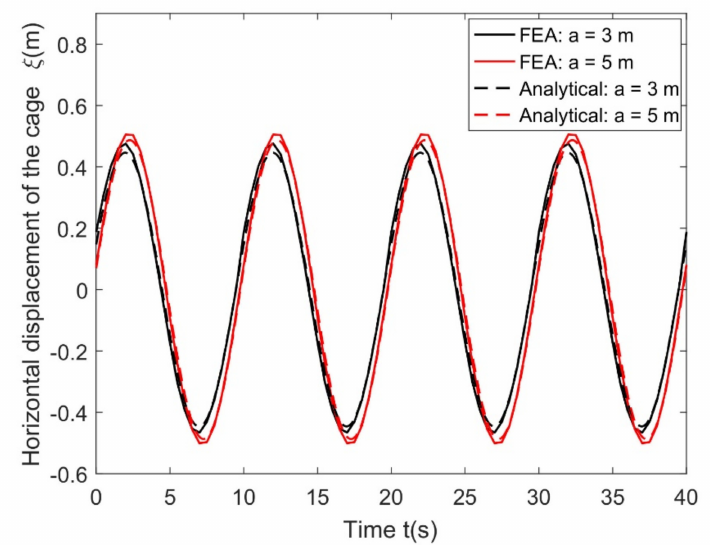
Figure 4. Comparison of the horizontal displacements for different cage radii a between the numerical FEA simulations and analytical results with h 2 = 50 m, h 1 = 7 m, k s = 10 3 Nm − 1 , and the other parametric values are the same as defined in Table